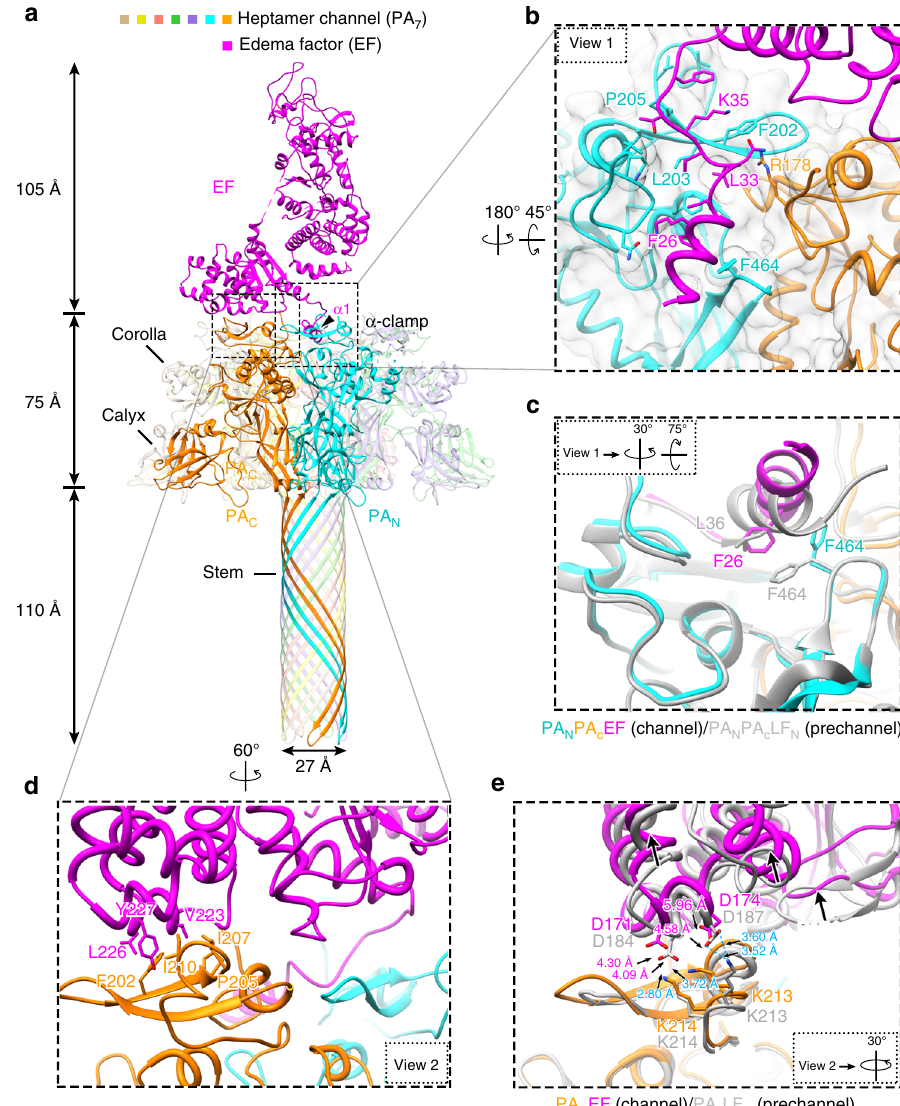
Fig. 2 Structure of EF-bound PA 7 channel (PA 7 -EF). a Overall structure of PA 7 -EF shown as ribbon. b Zoom-in view (view 1) of the PA 7 α -clamp site showing its detailed interactions with α 1 of EF. The cryo-EM density is shown as semi-transparent gray. c Rotated view 1 showing structure comparison of the substrate-binding α -clamp between PA 7 -EF channel (color) and PA 8 -(LF N ) 4 pre-channel (gray), except that the density is not shown for clarity. d Zoom-in view (view 2) showing the details of the PABD domain of EF binding to PA N and PA C . e Rotated view 2 showing the superposition of PA-bound EF (purple for EF, orange for PA) and PA-bound LF (gray for both PA and LF), except that the density is not shown for clarity. Hydrogen bonds are shown as dashed